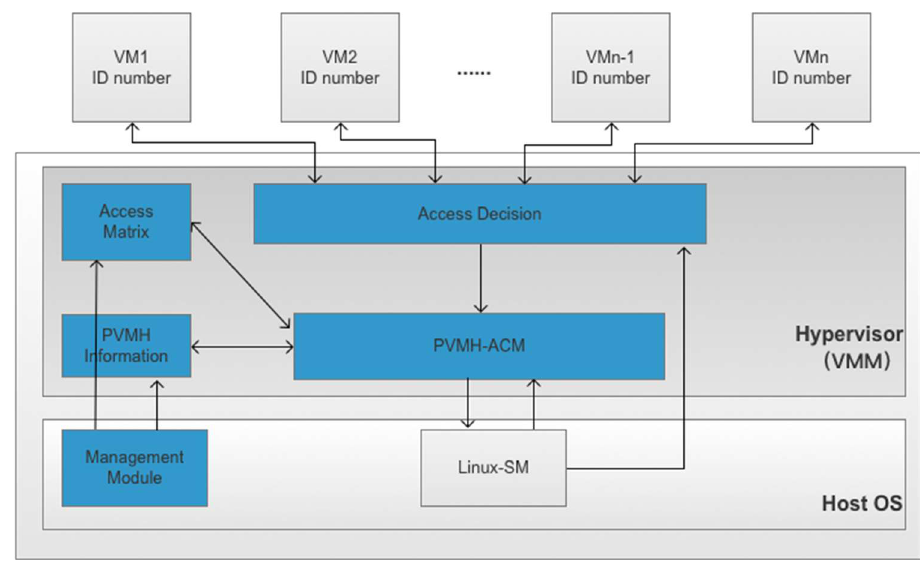
Figure 1. The PVMH architecture.